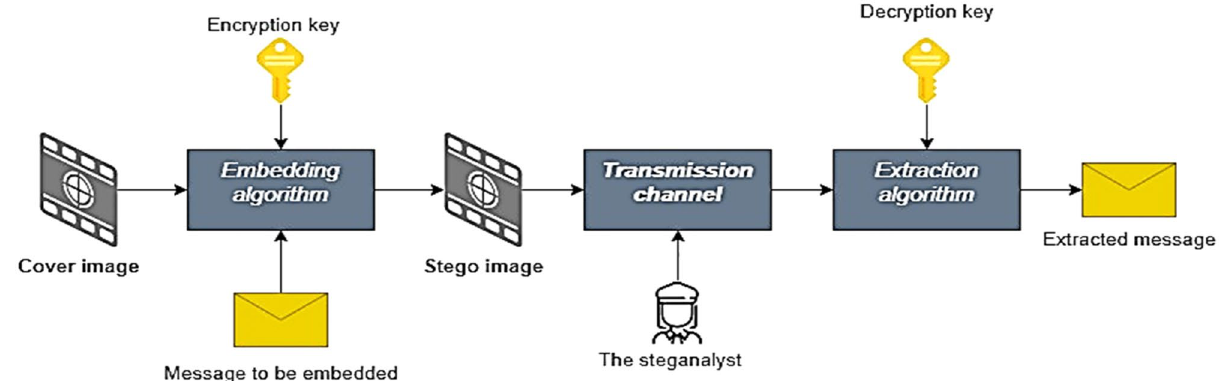
Figure 1. Block diagram of the steganographic